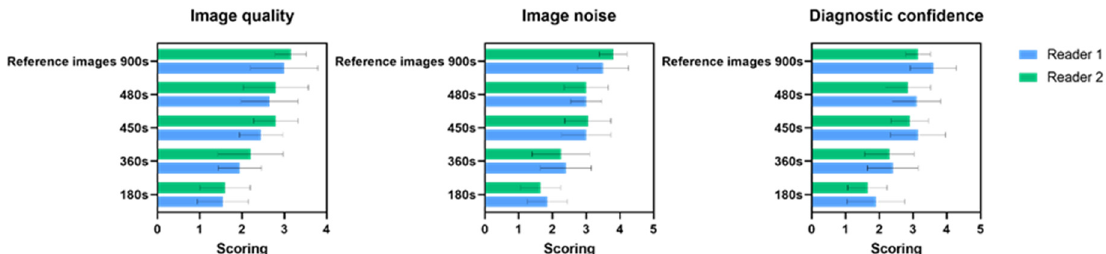
Figure 3. Bar plots showing the mean values and standard deviations of the clinical readings for each reader at different acquisition protocol strategies for the three-quality assessment (image quality, image noise and diagnostic confidence.